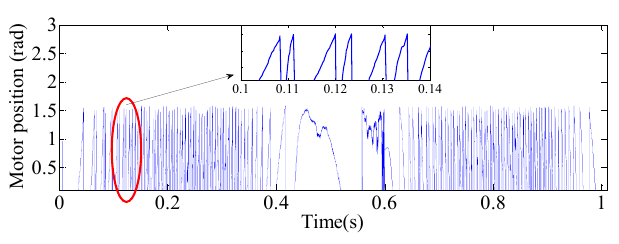
Fig. 9. Position response for the